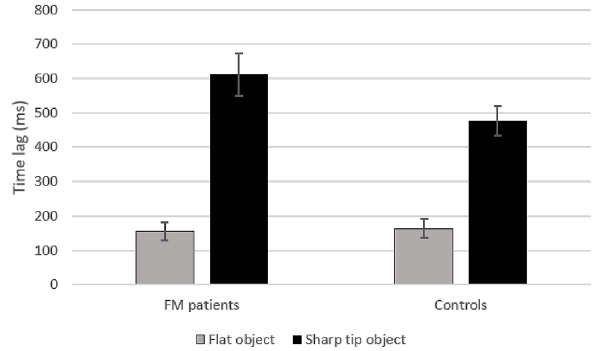
Figure 3. Detection time results. Time lag between the instant at which the agent touches the object and participant’s response time. For both groups (FM patients, Controls), data for flat object trials (grey) and sharp- tip object (black) trials are shown. Thin lines above histograms indicate standard error of the mean. Ordinates are in milliseconds.